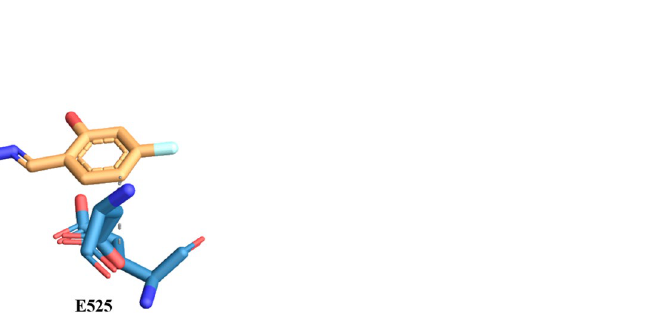
Figure 10. The simulated binding mode of compound 3j in the binding pocket of Jack Bean